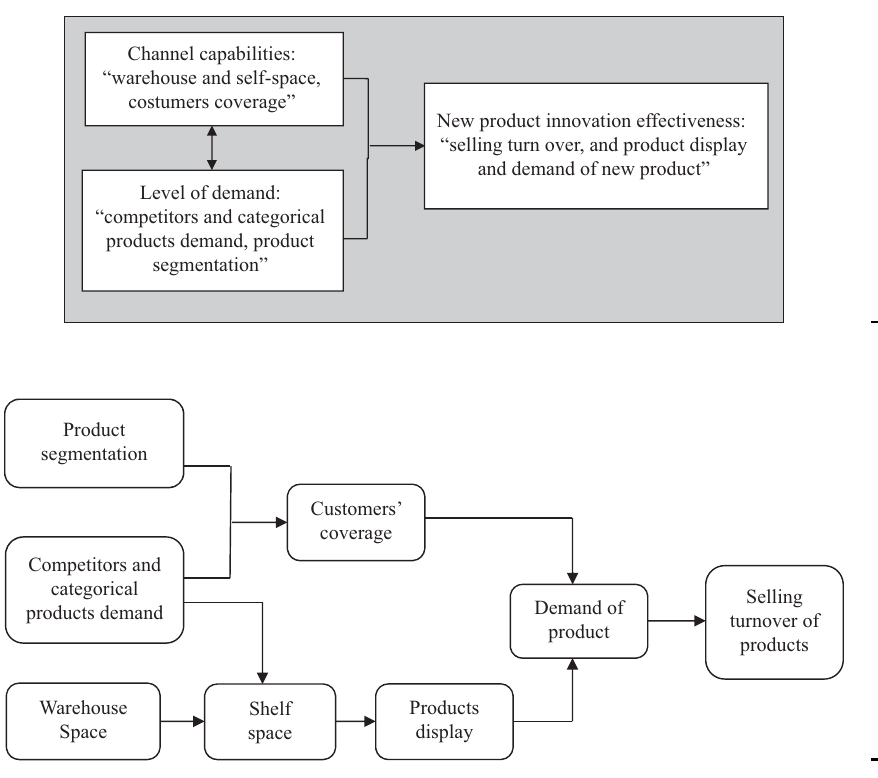
Figure 3. Channel capability